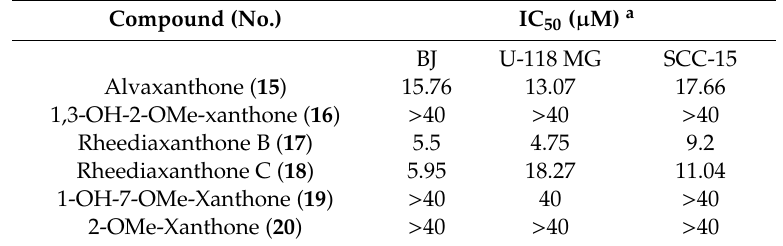
a Calculated by plotting the median cell viability (% of control) values against compound concentrations ( µ M), followed by abscissa transformation to the logarithmic form. The logarithmic regression led to the y = aln(x) + b equation, allowing to calculate the IC 50